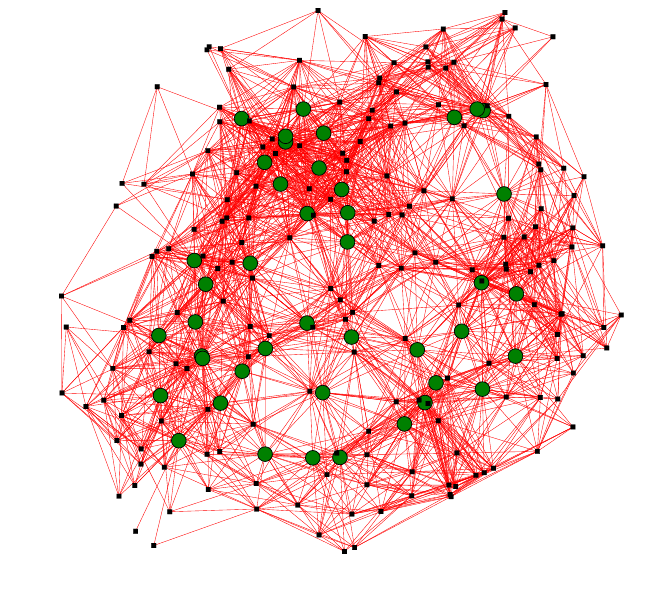
Figure 2. Example of an interference